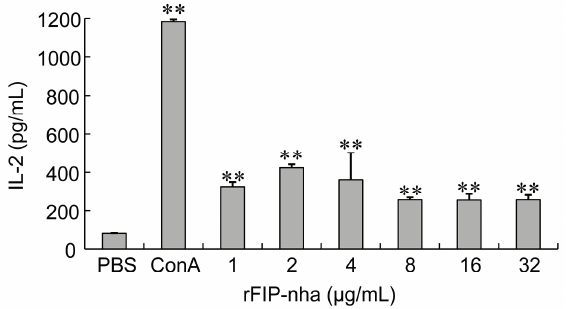
Figure 2. Effect of rFIP-nha on IL-2 release from mouse splenocytes. RFIP-nha (1, 2, 4, 8, 16, or 32 µg/mL) was used to treat mouse splenocytes for 48 h. Each bar represents mean ± SD ( n = 3). ConA: positive control; PBS: negative control. **: p < 0.01, compared to negative